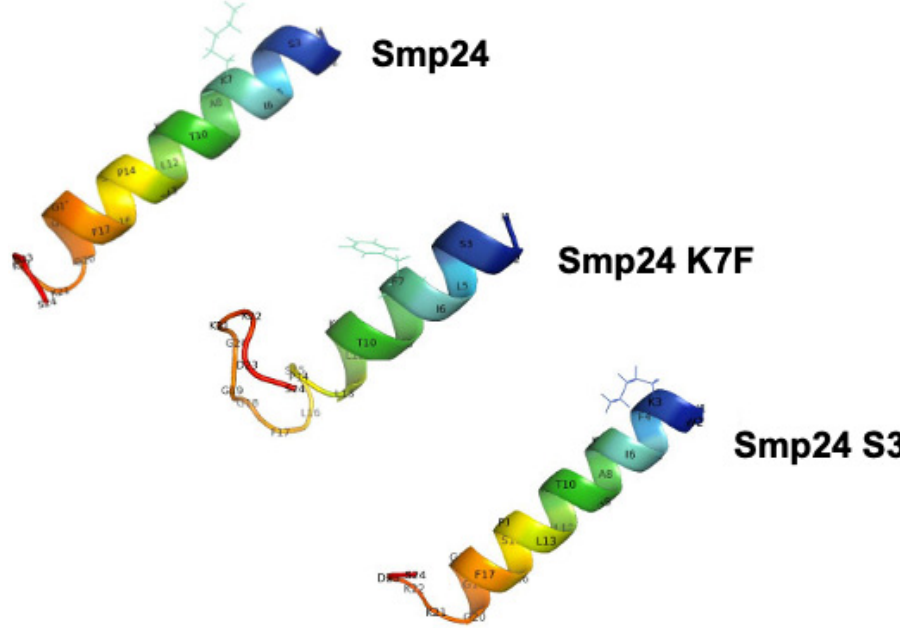
Figure 5. Secondary structures of Smp24 peptides visualized by PyMOL.